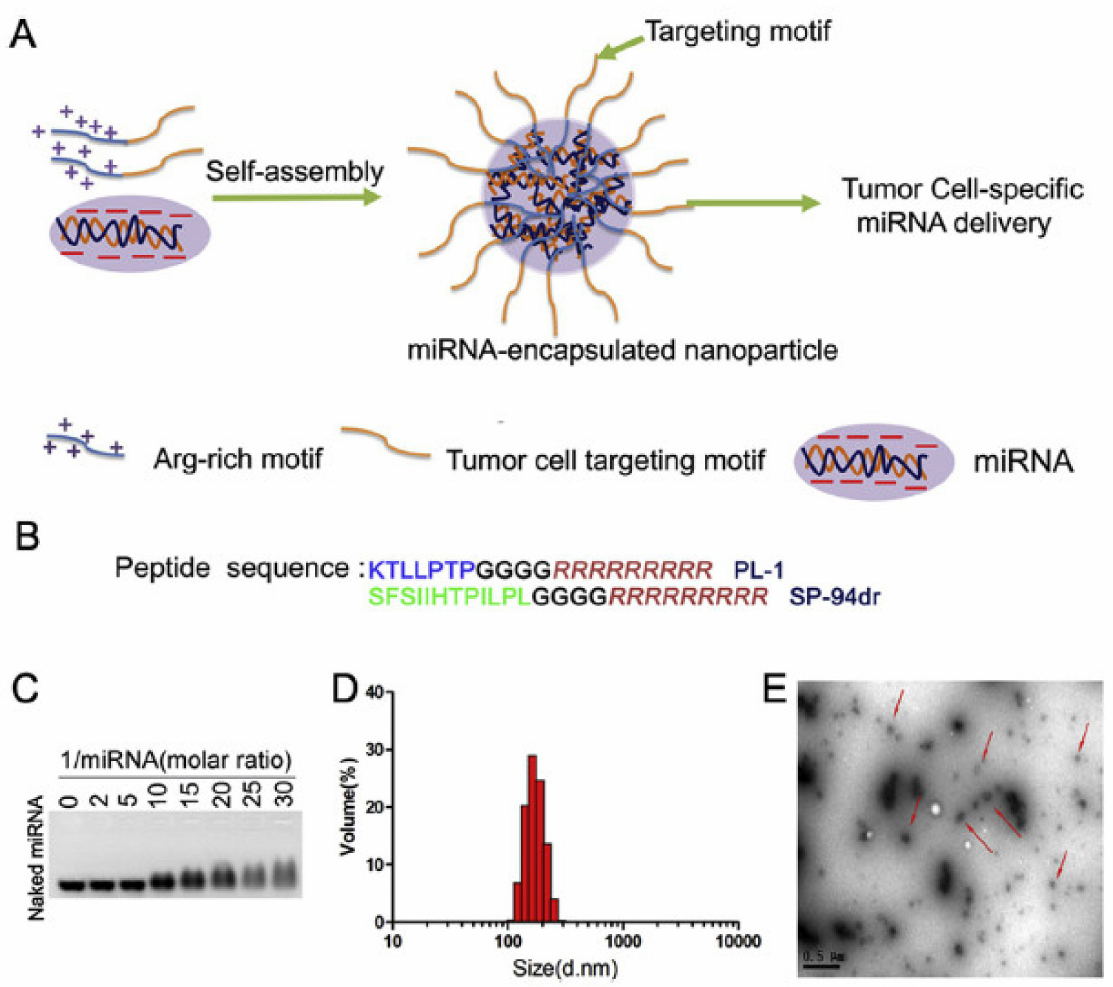
Figure 3. ( A ) The assembly of plectin-1 (PL-1) and miR-212 nanocomplex. ( B ) The PTP peptide is linked to the N-terminal of the arginine residues with a glycine linker. ( C ) An assay containing agarose gel was added to various PL-1 to miR-212 molar ratios. ( D ) The diameter of the nanoparticles was, on average, 180 ± 17 nm. ( E ) Transmission electron microscopy of the nanoparticles. Reprinted with permission from